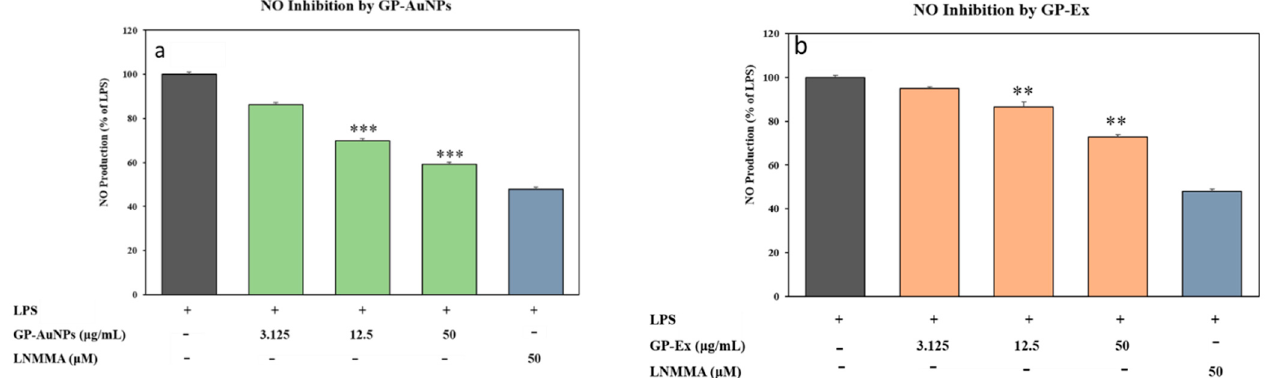
Figure 10. Effects on the production of NO GP-AuNPs ( a ) and GP extract ( b ). Macrophage RAW 264.7 cells were pretreated in both samples for 1 h and then stimulated with LPS (1 µ g/mL) for 24 h. The concentrations of nitrite were measured as described in the materials and methods. The data shown represent the mean values of three experiments ± SD. ** p < 0.01, *** p < 0.001 as compared with the group treated with LPS.